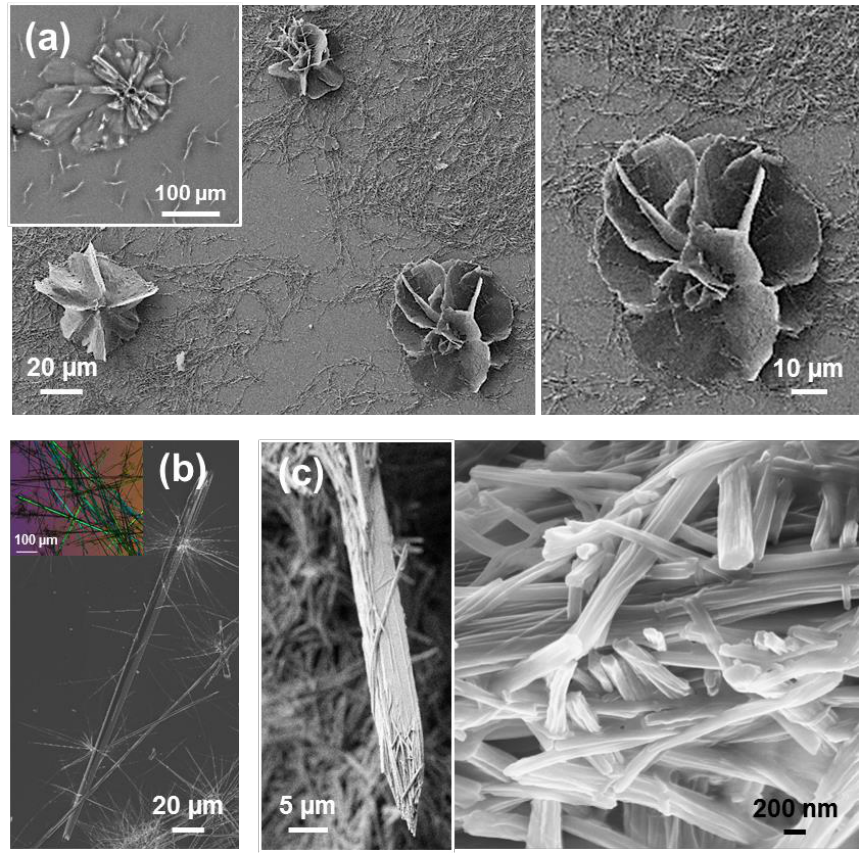
Figure 14. SEM and optical (inset in b ) micrographs of the structures obtained from Fmoc-FF-OFm solutions in ( a ) 1:4 HFIP:MeOH (1 mg/mL), ( b ) 4:1 HFIP: i PrOH (4 mg/mL), and ( c ) 4:1 HFIP:acetone (4 mg/mL) mixtures.